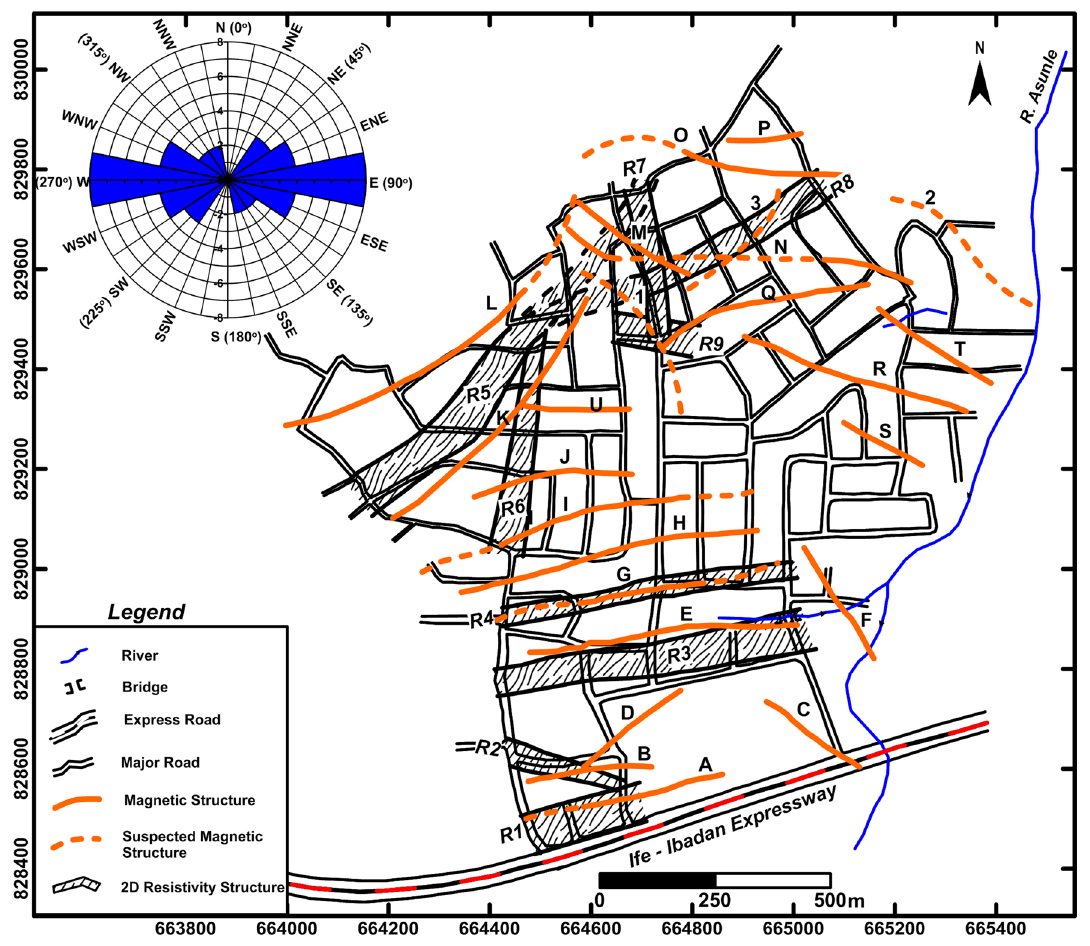
Fig. 13 Composite structure map of the study area (Modified from Adediran